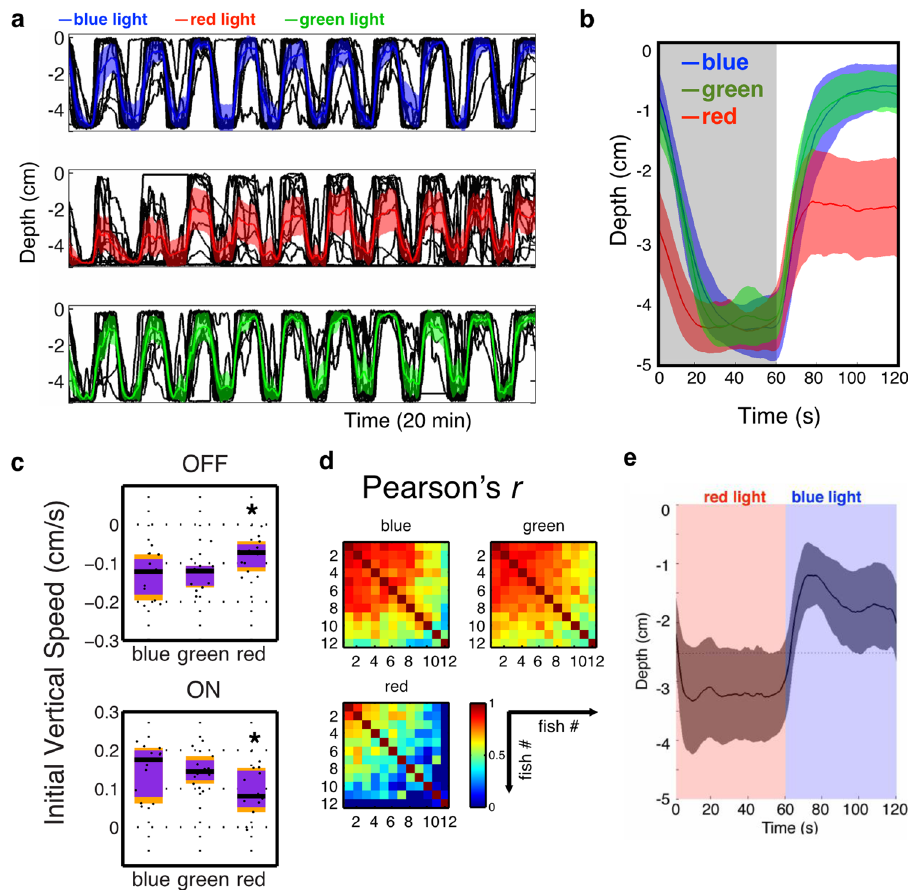
Figure 3. A comparison of vertical migration under blue, green and red light. ( a ) Vertical migration of larvae exposed to 10 cycles of blue (470 nm; 650 µ W/cm 2 ), green (525 nm; 580 µ W/cm 2 ) and red (660 nm; 465 µ W/ cm 2 ) light, which yield the same photon intensity, ~1.56 × 10 15 cm − 2 s − 1 . Black lines represent individual fish, while colored traces represent the average. Shadows indicate 95% CIs. n = 12 for each group. ( b ) Mean vertical migration from 10 dark-light cycles, averaged from panel (a), represented as mean ± 95% CIs. ( c ) Comparisons of initial 20 s vertical swimming speeds. Vertical speeds under blue and green lights are similar (Diving: Mann- Whitney U = 66, p = 0.76, two tailed, rank-biserial correlation = 0.083; climbing: Mann-Whitney U = 68, p = 0.84, two tailed, rank-biserial correlation = 0.056). Vertical speeds under blue and red light are different (Diving: Mann-Whitney U = 31, * p = 0.0097, one tailed, rank-biserial correlation = 0.60; Climbing: Mann- Whitney U = 36, p = 0.040, two tailed, rank-biserial correlation = 0.50). Vertical speeds under green and red light are different (Diving: Mann-Whitney U = 30, p = 0.0083, one tailed, rank-biserial correlation = 0.58 Climbing: Mann-Whitney U = 34, p = 0.015, one tailed, rank-biserial correlation = 0.53). ( d ) Correlation coefficient of vertical position across time during 10 dark-light cycles. Correlation matrices are different (blue vs green: χ 2 = 3288, df = 66, p < 0.0001; blue vs red: χ 2 = 5534, df = 66, p < 0.0001. Jennrich’s χ 2 test). ( e ) Behavior under alternating red and blue light cycles with the same photon intensity ~1.56 × 10 15 cm − 2 s − 1 , represented as mean ± 95% CIs. Larvae display vertical migration, with the vertical position under blue light being higher than the vertical position under red light (Mann-Whitney U = 118, p = 0.008, two tailed, rank-biserial correlation = 0.64, n =